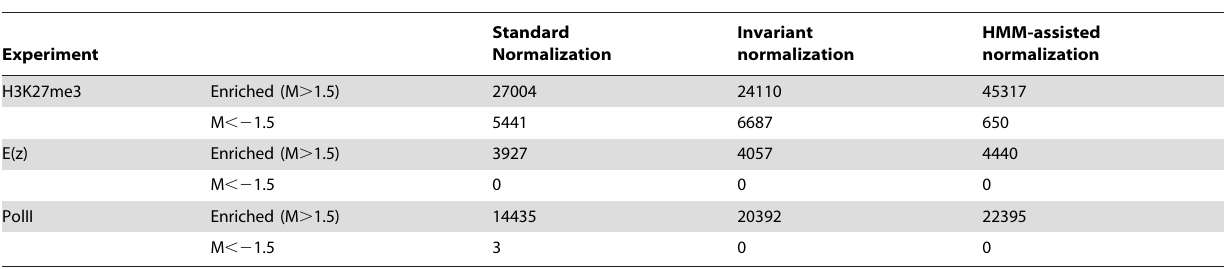
Table 1. Normalization of three ChIP-chip data